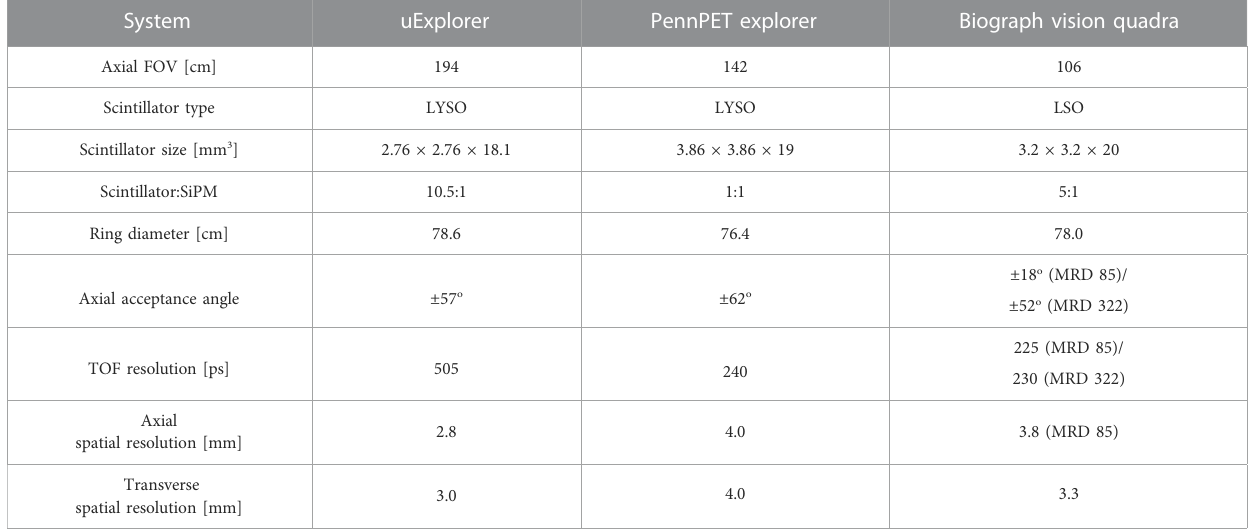
TABLE3SummaryoftotalbodyPETsystems.TheBiographVisionQuadrareconstructionscanbeperformedatamaximumringdistanceof322crystals(MRD322) or 85 crystals (MRD 85) [152, 155,